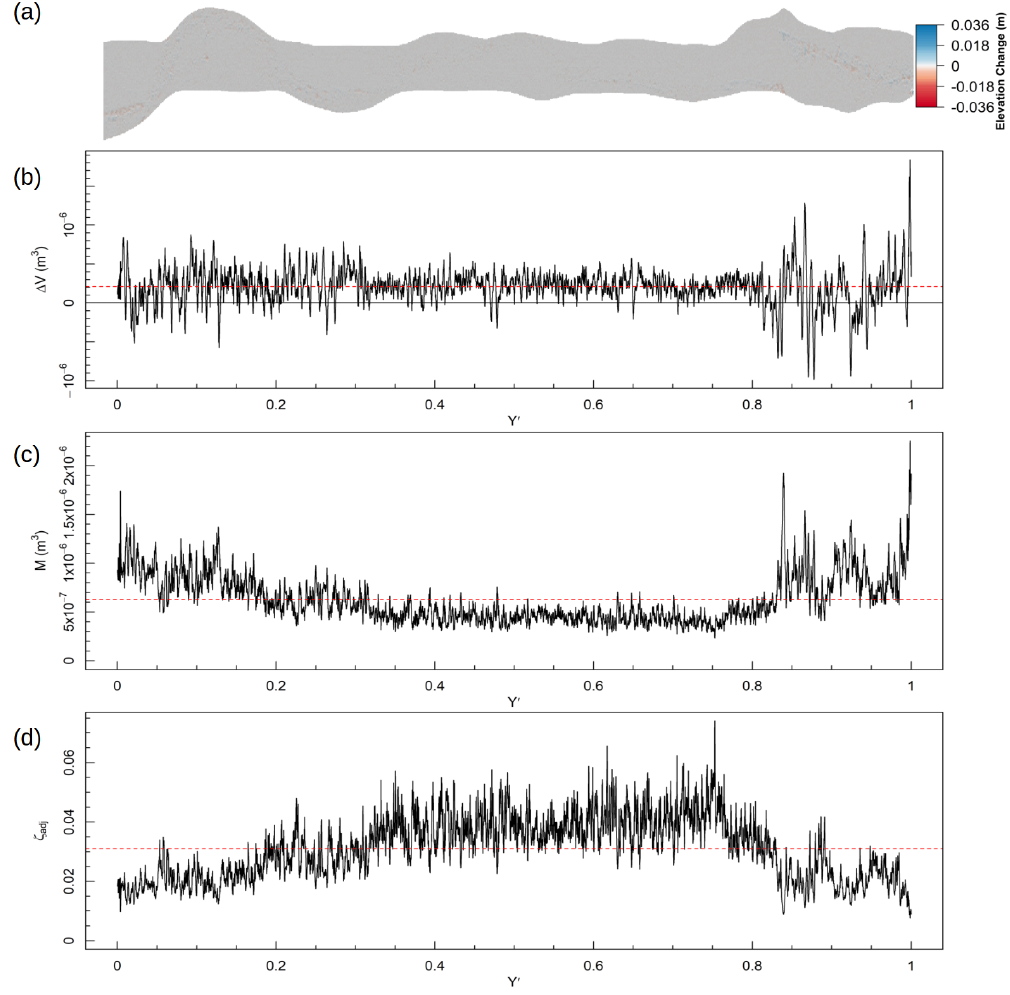
Figure 11. Example calculation of ζ for T = 465–480min in the mobile-bank experiment. See Fig. 8 for